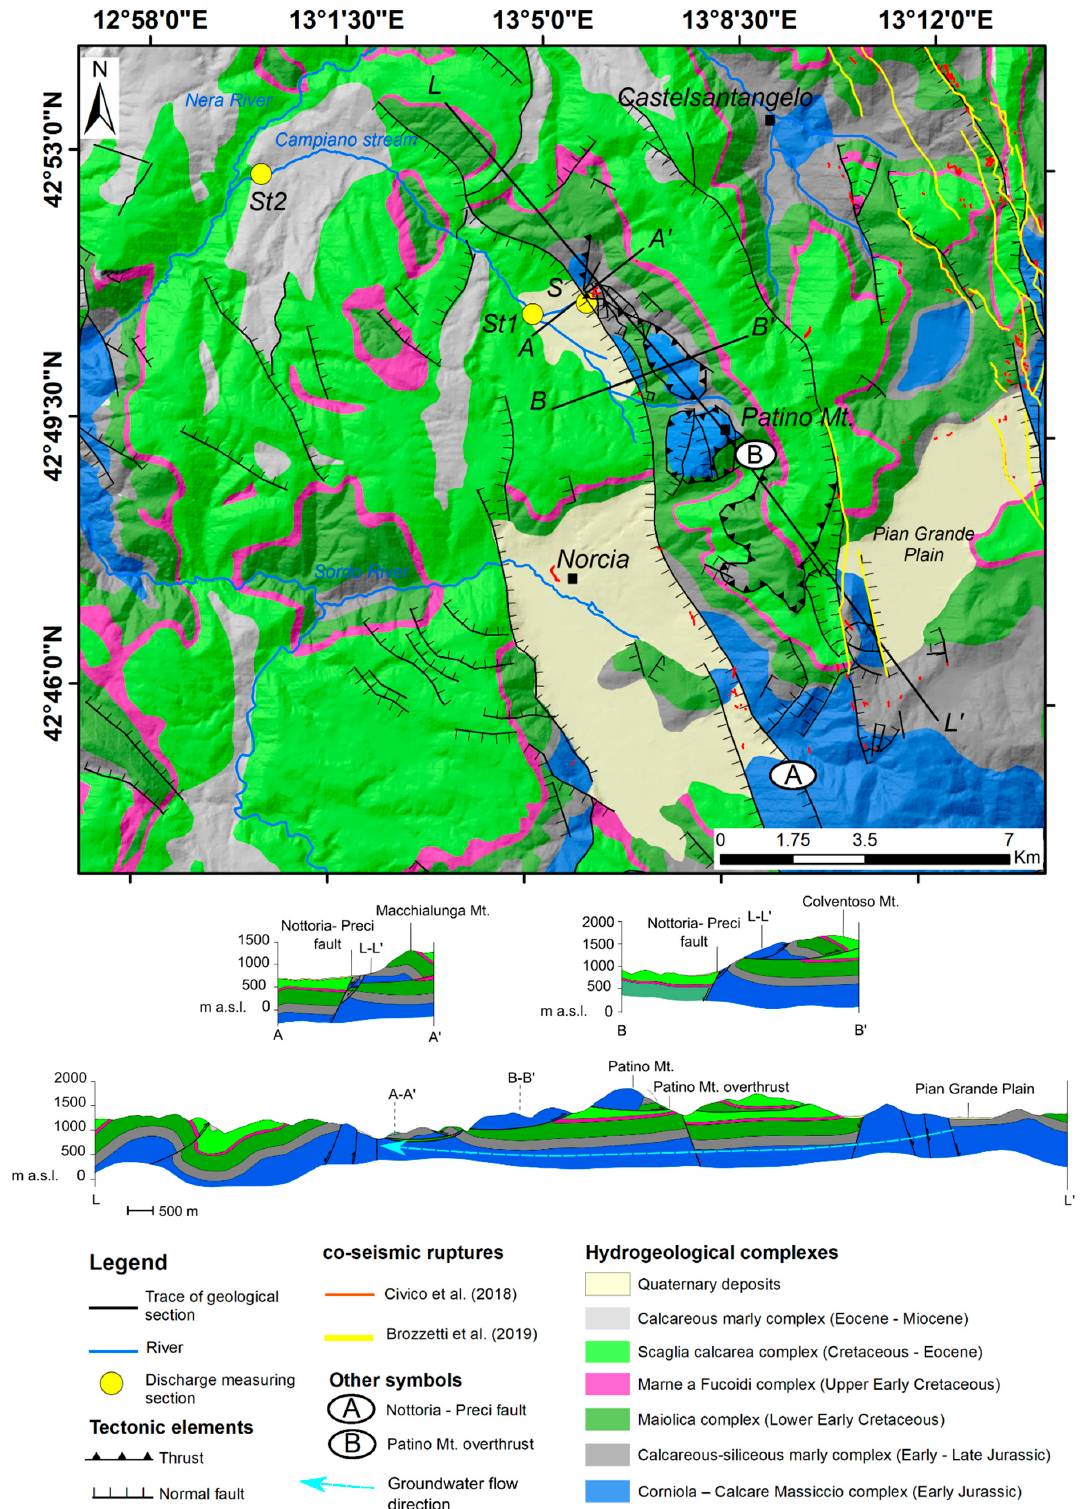
(Figure 3) with discharge values decreasing from about 0.5 m 3 /s to 0.2 m 3 /s in St1 and from about 1.2 m 3 /s to 0.6 m 3 /s in St2.